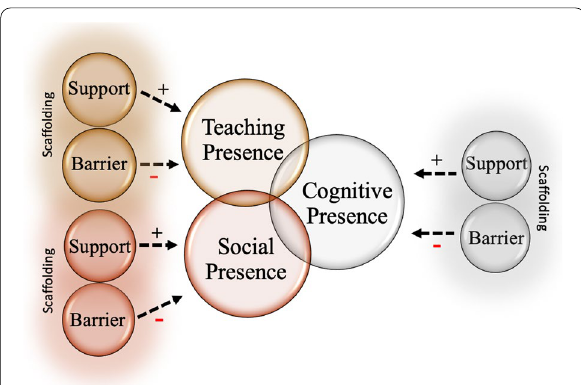
Fig. 2 The Community of Inquiry and Scaffolding. Each support and barrier influenced its designated presence/attribute and each presence/attribute ultimately led to a specific cognitive presence for instructors and students. ( ) indicate positive influences in + each presence or attribute and (–) indicates negative influences. Scaffolding is represented as the glow around each support and barrier as it impacts